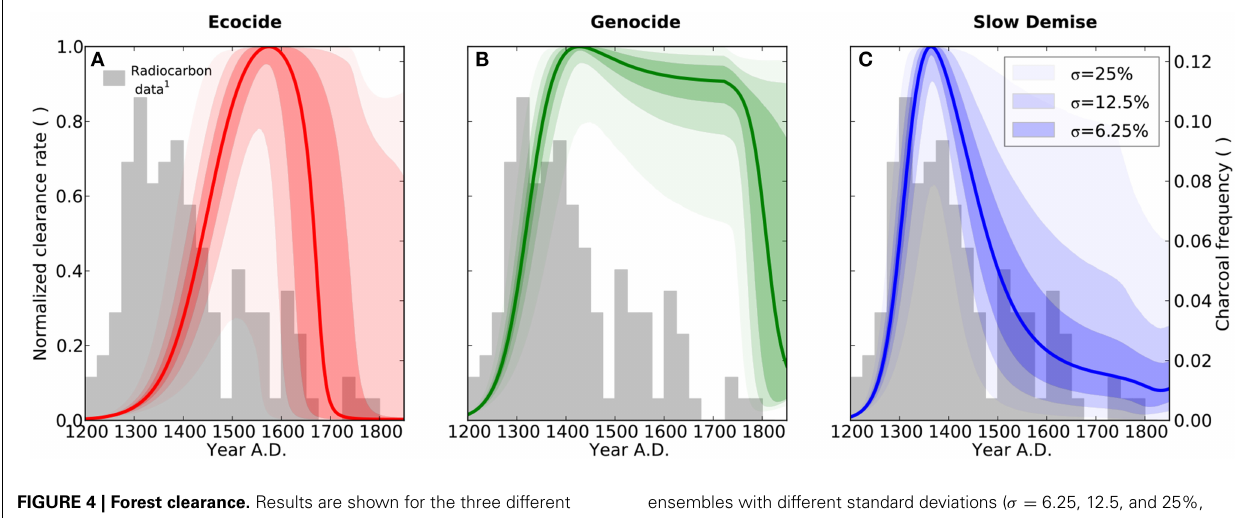
ensembles with different standard deviations ( σ = 6.25, 12.5, and 25%, respectively) of the normal distribution from which the perturbed parameters of the ensemble were drawn. The bars show the relative frequency of dated charcoal remains used here as a semi-quantitative proxy for the intensity of slash-and-burn activities, 1: Radiocarbon dates compiled by Hunt and Lipo (2006), see Table A1 and Materials and